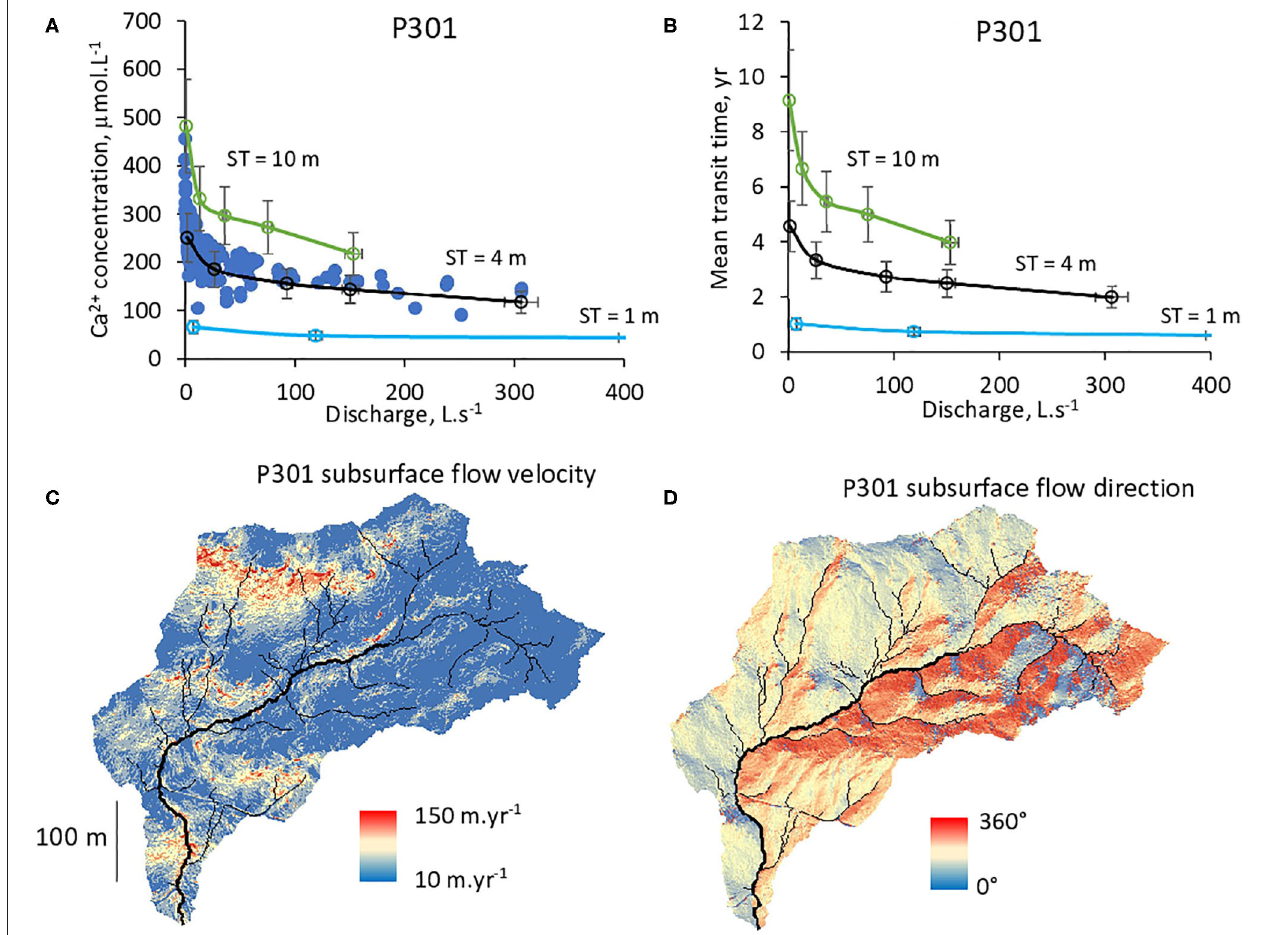
FIGURE 7 | Hydrogeochemical modeling of the P301 watershed. (A) C-Q diagram for Ca 2 + and stream water. Dark blue points represent measured values. Green, black and light blue lines represent modeling results with saturated thicknesses (ST) of 10, 4, and 1m, respectively. (B) Modeled mean transit times. (C) Map of subsurface flow velocity generated with a saturated thickness of 4m. (D) Map of subsurface flow direct ion generated with a saturated thickness of